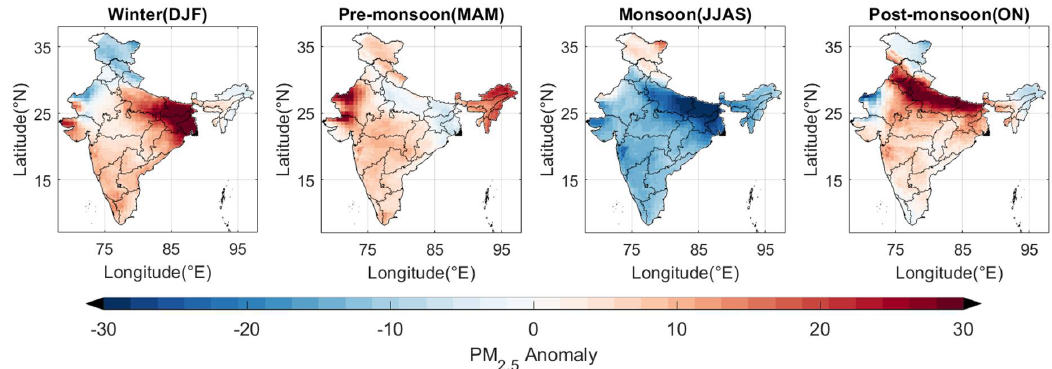
Figure 6. Spatial patterns of seasonal PM 2.5 anomaly (i.e., the difference between mean seasonal and mean annual PM 2.5 ) averaged over the 20-year (2000–2019) period over India.